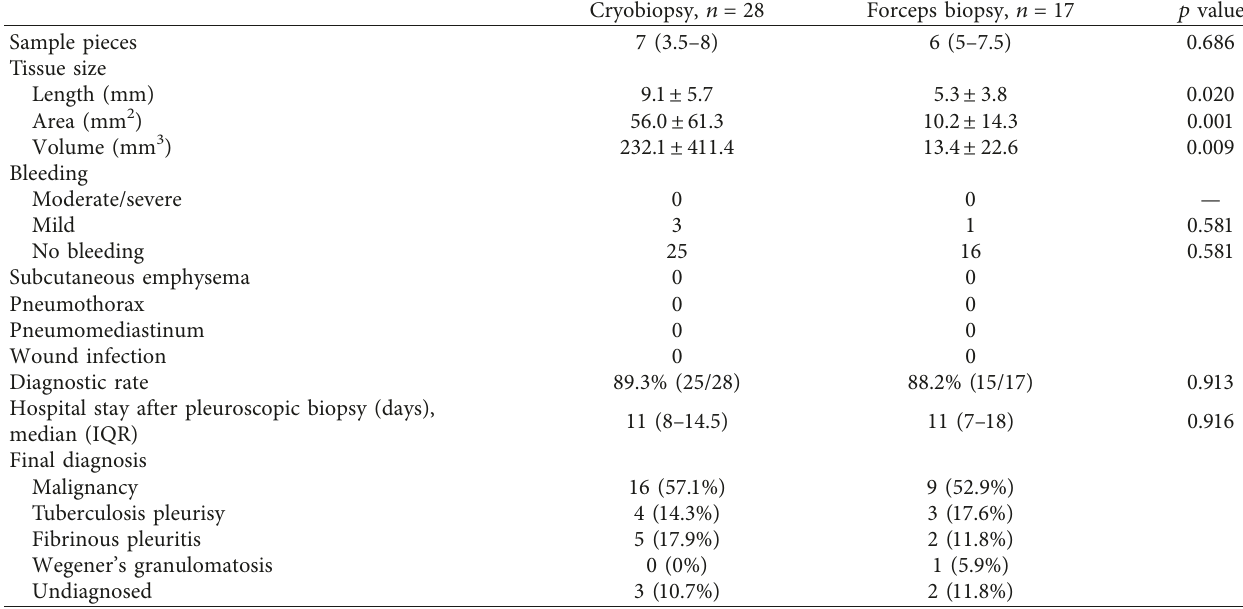
Table 2: Final diagnoses and complications.